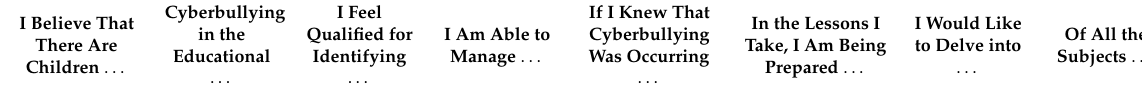
Table 4. Correlation of the items related to the indexes Concern, Confidence and